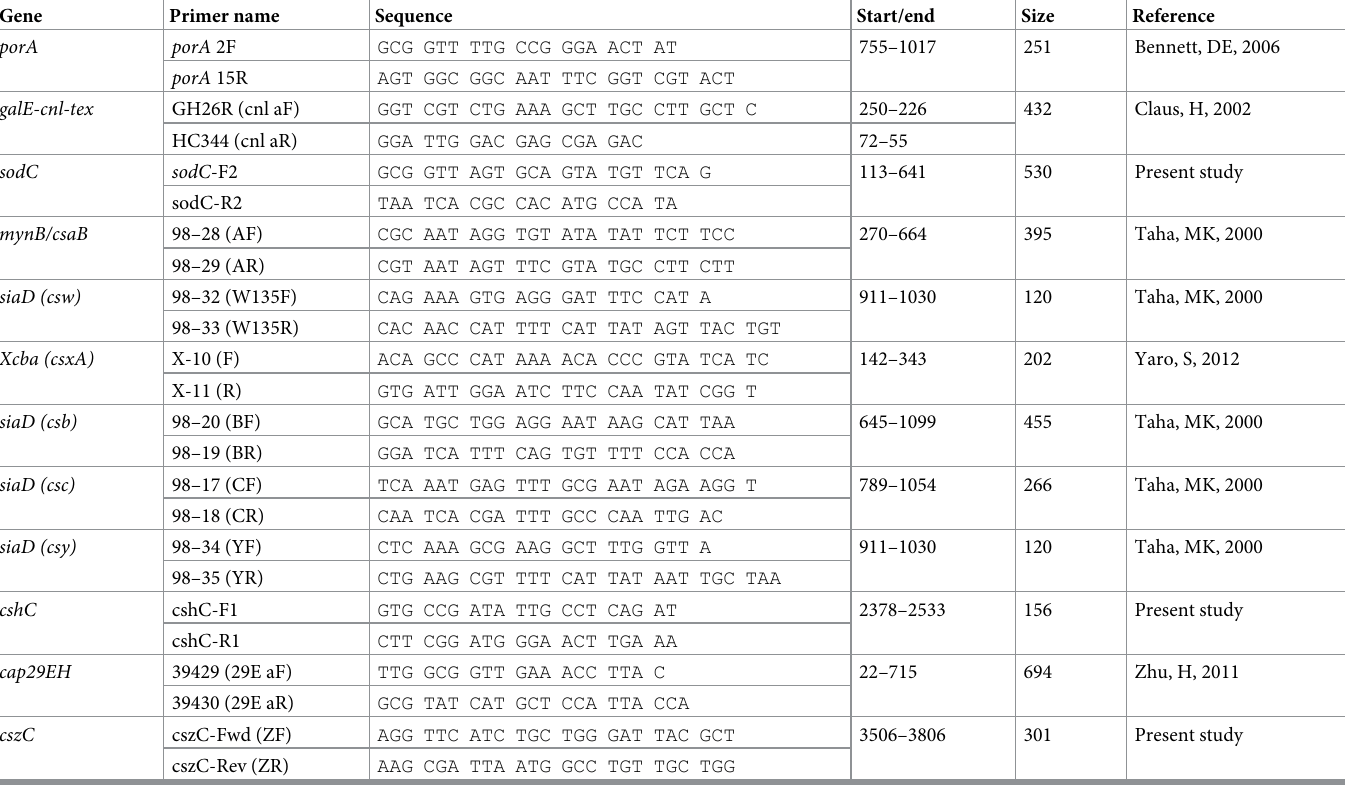
Table 1. Primer sequences for gel-based PCR.